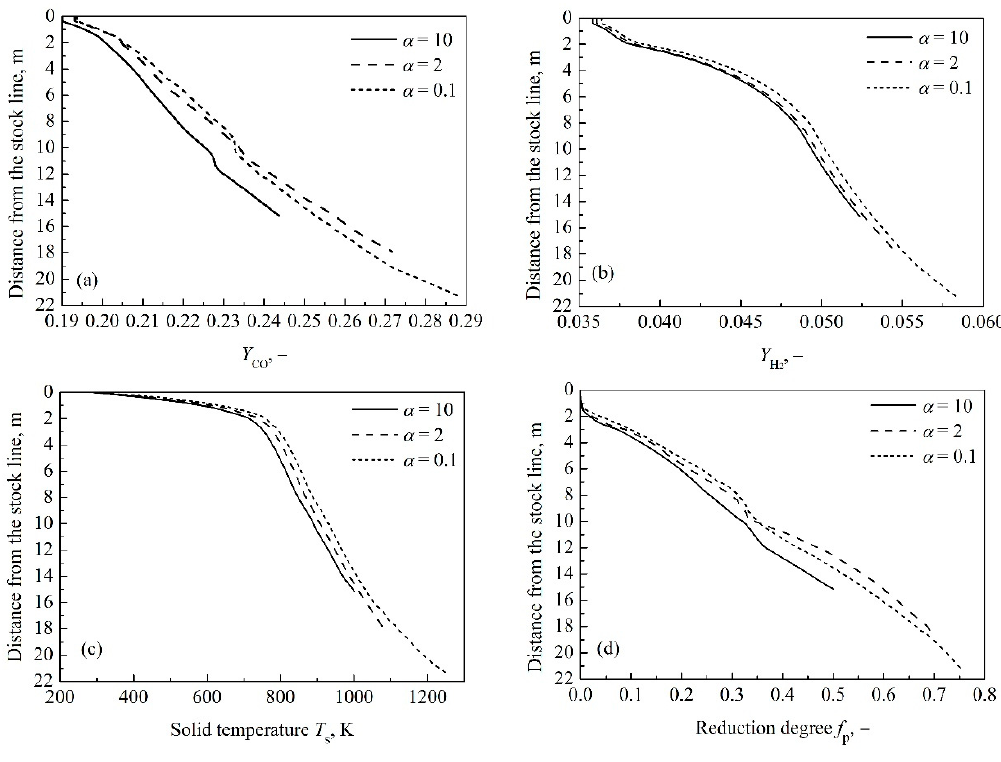
Figure 4. E ff ect of coke reactivity on volume fraction distributions of CO ( a ) and H 2 ( b ), temperature Energies 2020 , 13 , x FOR PEER REVIEW 11 of 14 Figure 4. Effect of coke reactivity on volume fraction distributions of CO (a) and H 2 (b), temperature distribution ( c ) and reduction degree distribution ( d ) in indirect reduction region. distribution (c) and reduction degree distribution (d) in indirect reduction region.